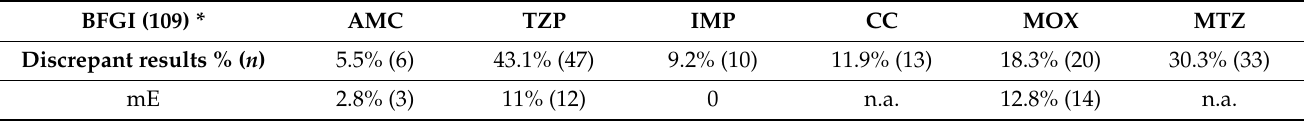
Table 3. Minor errors (mE), major errors (ME), and very major errors (VME) for disc diffusion versus MIC testing for Bacteroides fragilis group isolates